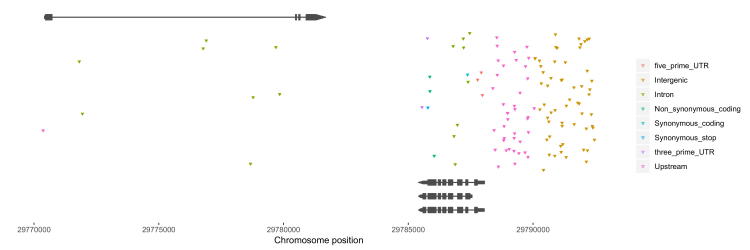
SNPs between two maize lines identified using the genome browser functionality of MaizeSNPDB. SNP sites are represented as inverted triangles with differing colors in the main plot region. Structure of four annotated mRNAs are displayed at the top and bottom of the main plot region. X-aixs, coordinates of the genomic region.